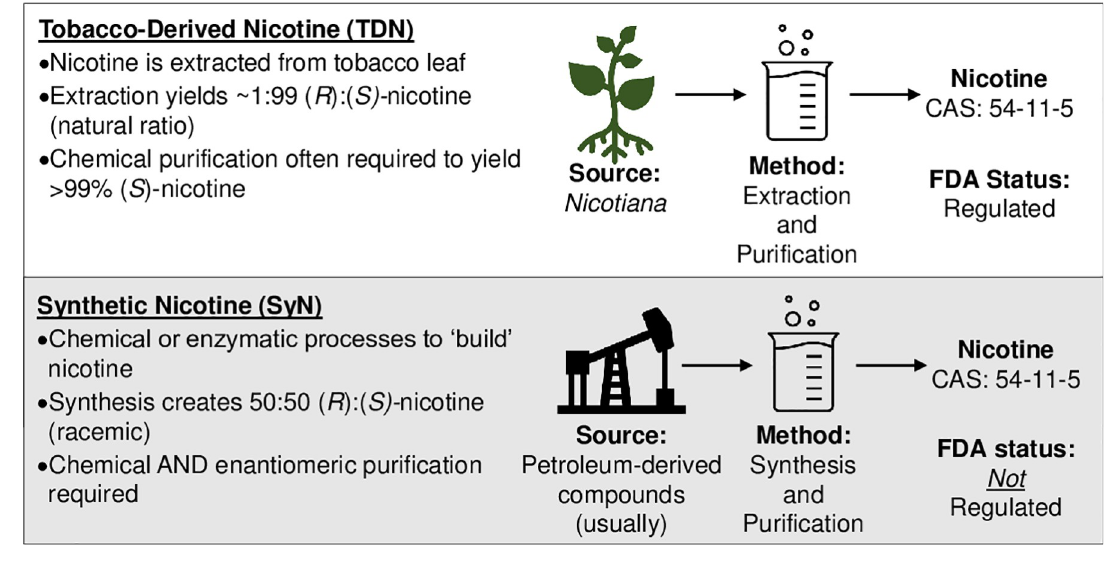
Fig 2. Nicotine production